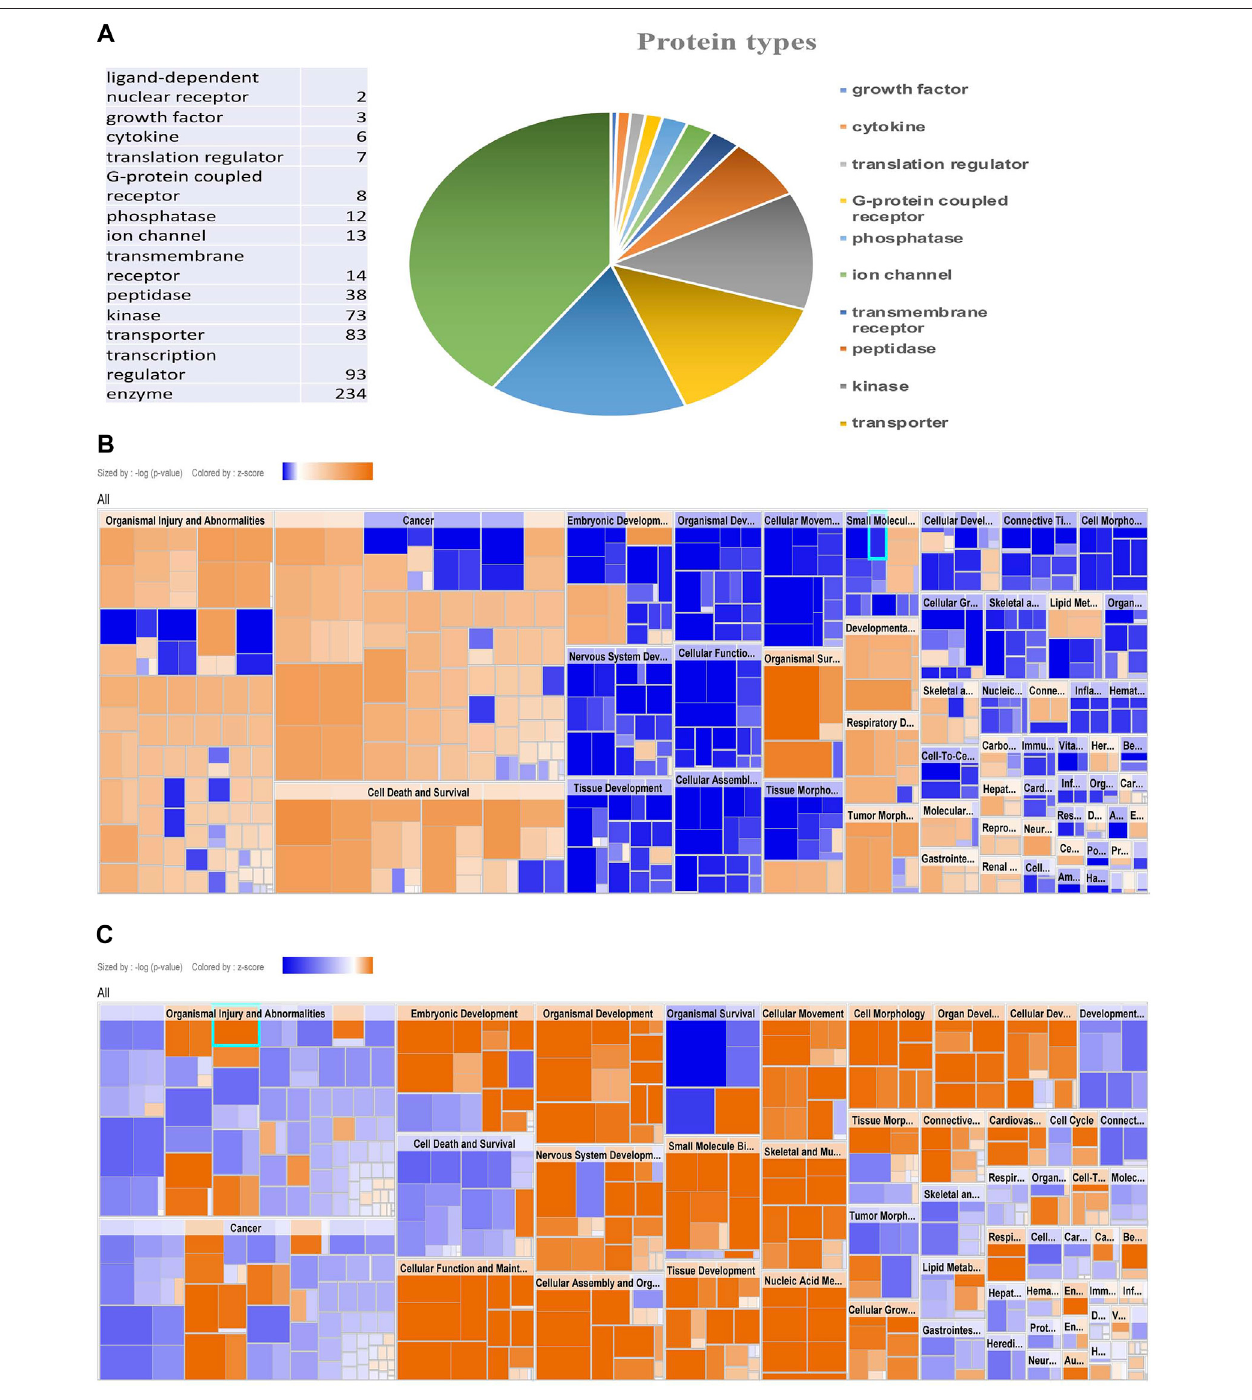
FIGURE 2 | Protein enrichment analysis by IPA showing types of protein and Comparative heat map. Pie chart showing types of protein mapped by IPA (A) , Disease function Heat map of male (B) and female (C) zebra fi sh brain proteome upon hypoxia treatment.